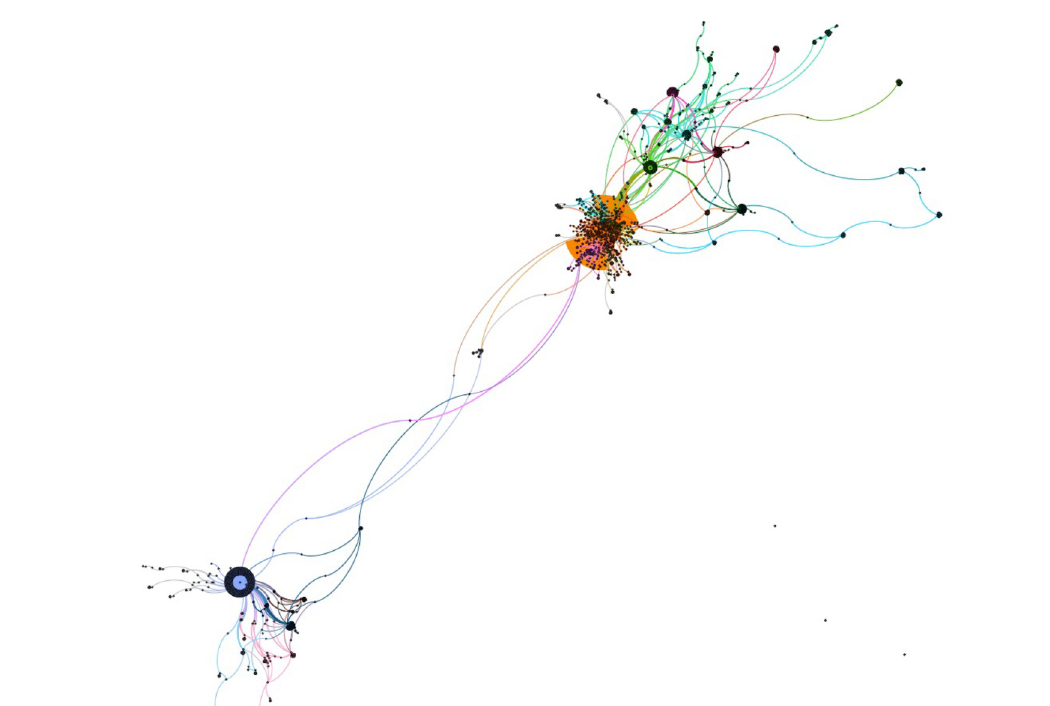
Figure 2. Identified user clusters with fake tweets (414 user clusters). intercept is A with unexplained components ( residuals ) k at the time‐, tweet‐, and user cluster‐levels: e g . To model the diffusion shape (broadcast vs. k